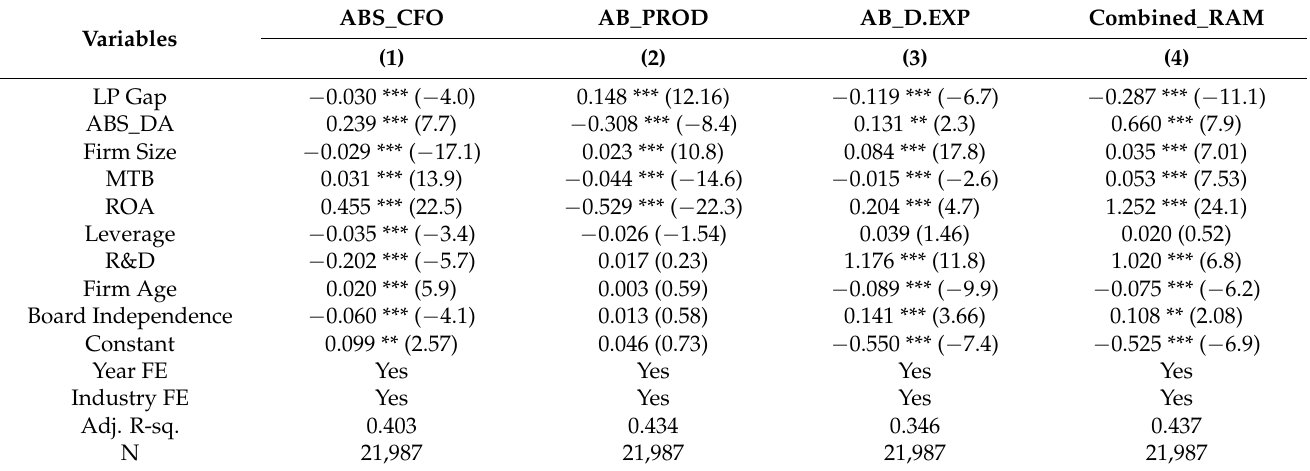
Table 4. Real activities manipulation on labor productivity gap. (** indicates level of significance at 95% level and *** indicates level of significance at 99%